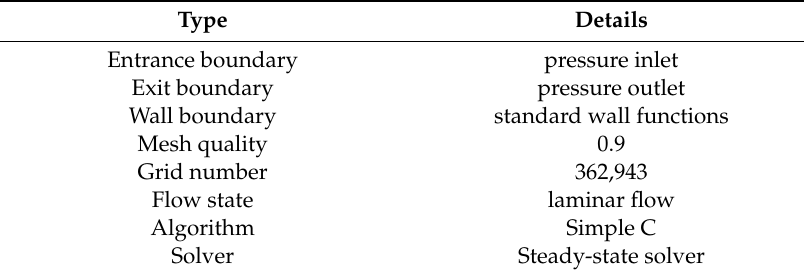
Table 3. Details about boundary, mesh and